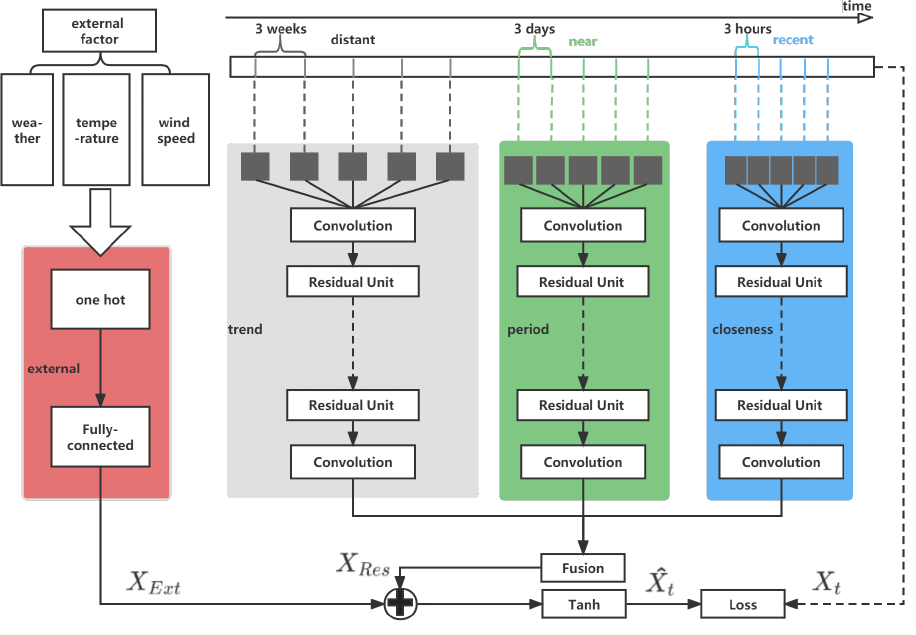
Figure 1. The schematic diagram of the ST-ResNet [26]